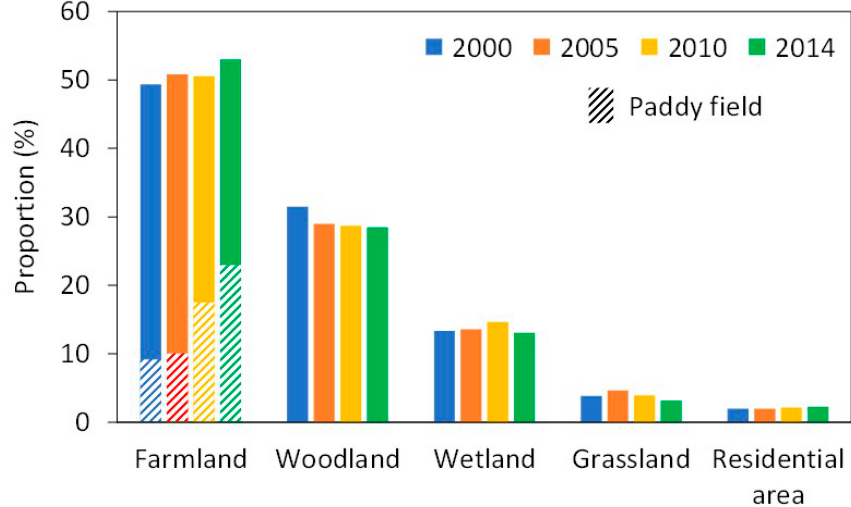
Figure 2. Proportion of main land use types in the Sanjiang Plain.